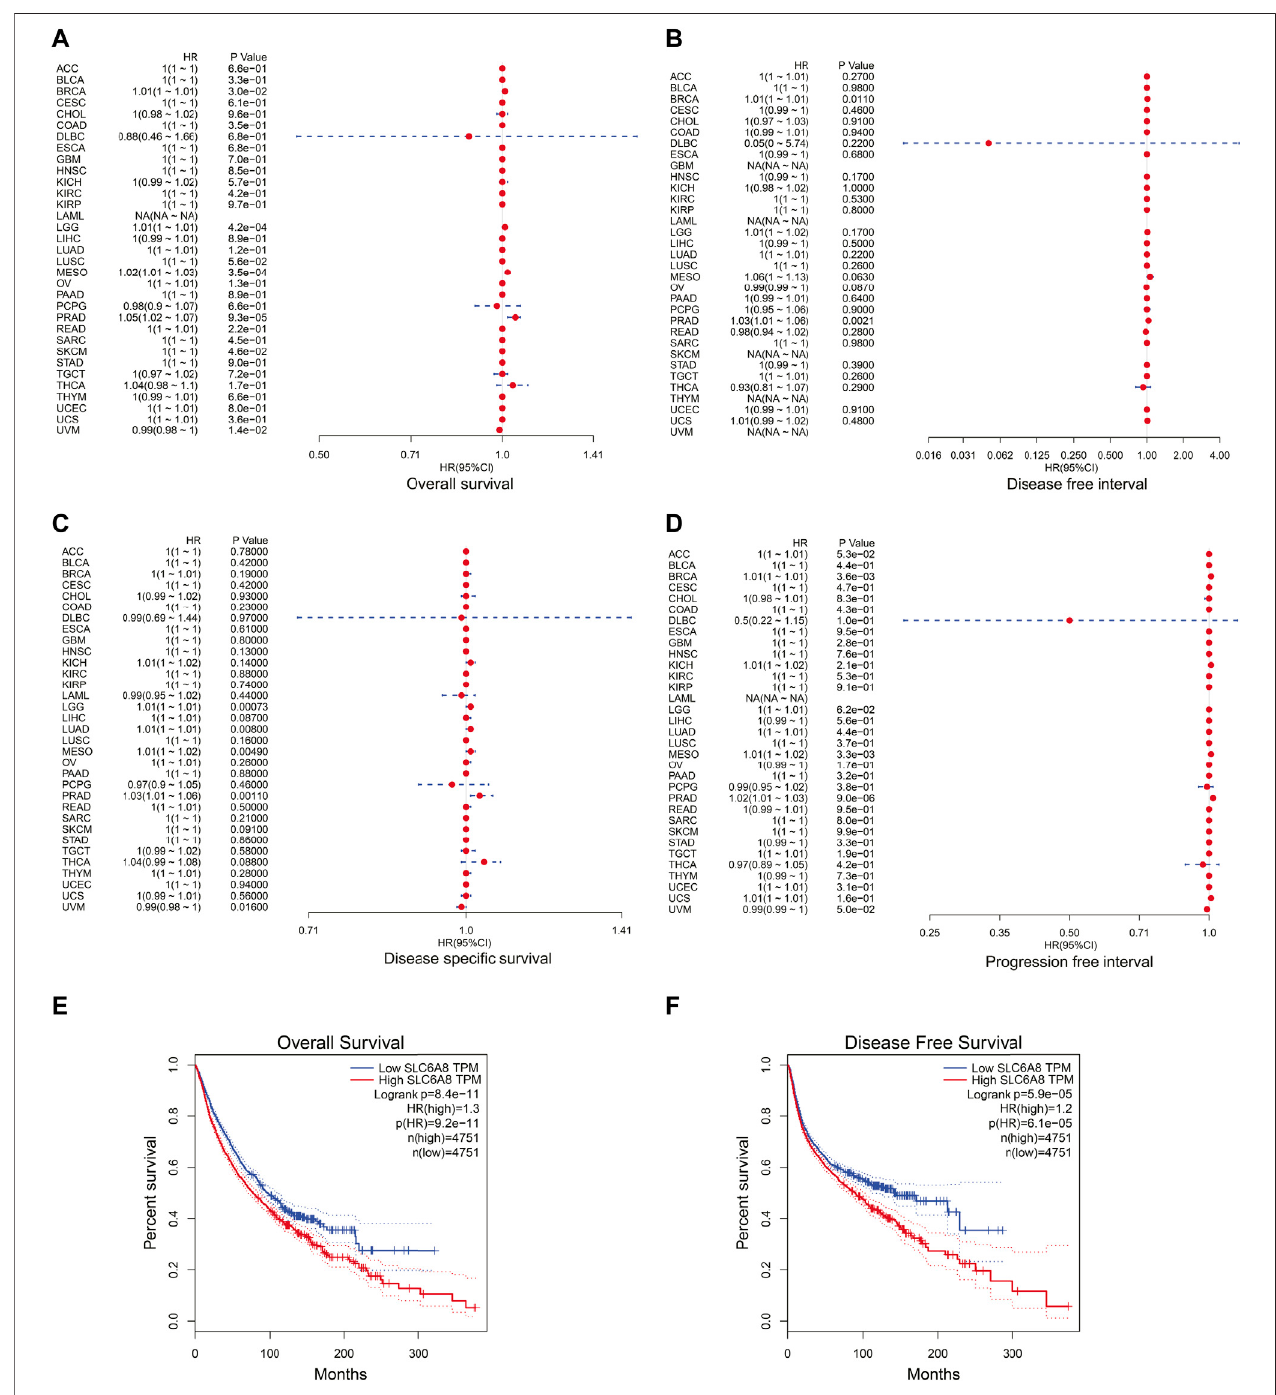
FIGURE 2 | Correlation between SLC6A8 expression and cancer patients ’ survival. (A – D) Forest plots of hazard ratios of SLC6A8 in different cancers regarding overall survival (A) , disease-free interval (B) , disease speci fi c survival (C) , and progression free interval (D) . (E) and (F) Kaplan-Meier survival curves of overall survival (E) and disease-free survival (F) according to SLC6A8 expression in pan-cancer according in GEPIA2. * p < 0.05, ** p < 0.01, *** p < 0.001.